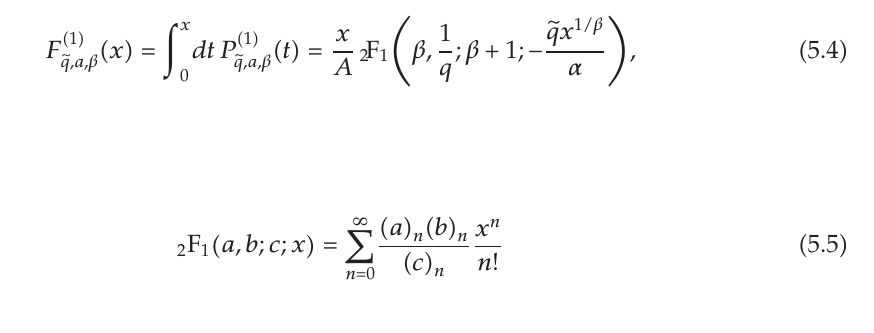
As (cid:2) q → 0, B (cid:2) β, 1 / (cid:2) q − β (cid:3) ≈ (cid:2) q β Γ(cid:2) β (cid:3) , since 1 / (cid:2) q (cid:7) β , one retrieves the stretched exponential (cid:2) 1 (cid:3) (cid:2) x (cid:3) (cid:7) β β e − β (cid:2) x/a (cid:3) 1 /β / (cid:4) aβ Γ(cid:2) β (cid:3)(cid:5) or P (cid:2) 1 (cid:3) function P 0 ,a,β